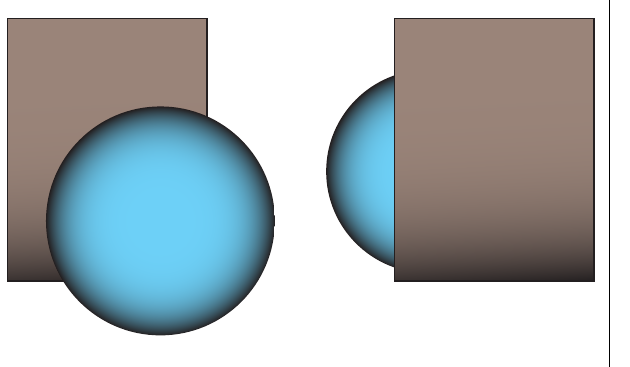
FIGURE 1 |Ambiguity of “the ball is in front of the block” inYélî Dnye. The expression describes either scene.